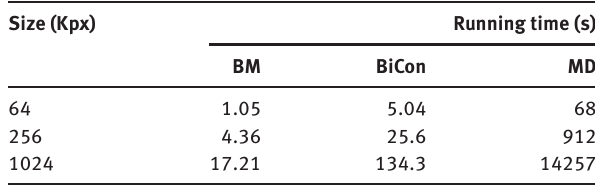
Table 1: Average running time for color